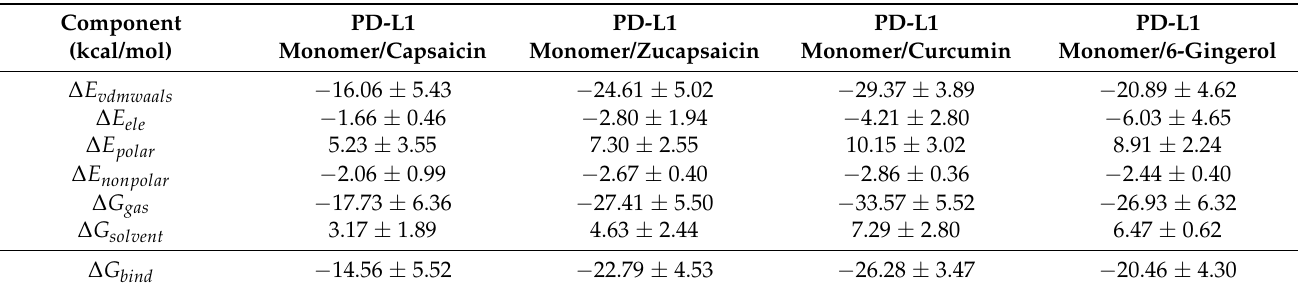
Table 2. The components of binding free energies of the PD-L1 monomer/capsaicin, PD-L1 monomer/zucapsaicin, PD-L1 monomer/curcumin and PD-L1 monomer/6-gingerol systems (kcal/mol).